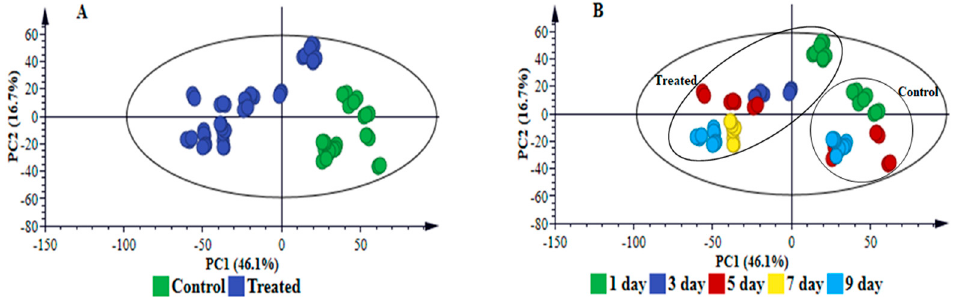
Figure 1. Principal component analyses of the electrospray ionisation (ESI) negative data for sorghum NS 5511 (BT) extracts. ( A ) represents an 11-component model, explaining 84.2% variations in Pareto-scaled data, X, and the amount of predicted variation by the model, according to cross-validation, is 74.1%. ( A , B ) represent the same principal component analysis (PCA) scores plot; with ( A ) coloured according to condition (control vs . infection treatment) and ( B ) coloured according to time. This two-dimensional scores space, spanned by the first two PCs, reveals infection-related sample clustering (treated/infected = blue, controls = green) and time-related clustering, (days 1–9 post infection) respectively. Note: to determine the group (control/infected) to which the time-related clusters in ( B ) belong, link to the corresponding positions in ( A ) .